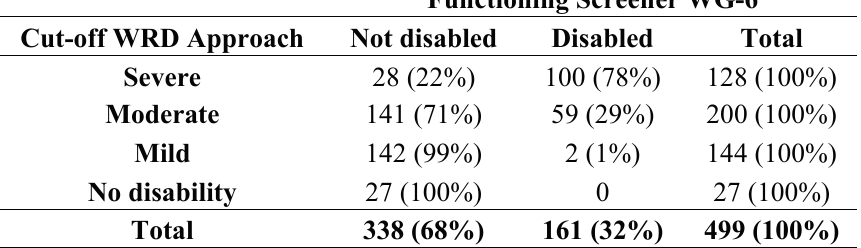
Table 4. Comparison of the person identified as disabled vs . not disabled with the screener approach and the persons in the severe, moderate, mild and no disability groups with the World Report on Disability (WRD) approach. WG-6, Short Set of Questions on Disability, Washington City